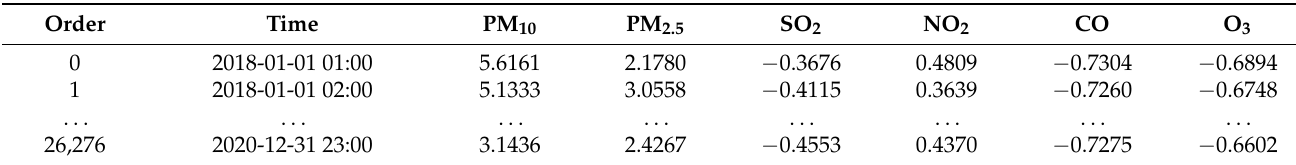
Table 2. The examples of the dataset D .